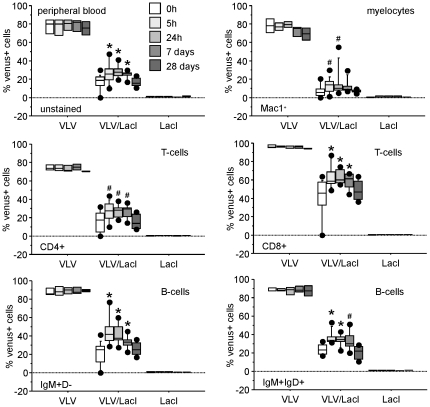
Transgene re-expression in vivo.Mice of the indicated genotypes were treated i.p. with 1 mg IPTG and levels of Venus+ cells in T-, B- and myeloid subsets in the peripheral blood were quantified by FACS analysis following the indicated times. Results of three independent experiments and 3 (VLV and LacI) or 6 (VLV/LacI) animals/genotype are represented as box plots. Box length equals interquartile range. Circles represent minimal and maximal values; *p<0.001; #p<0.05. F2 generation offspring of VLV founder A3 were crossed with LacI mice. Single-, double-, and non-transgenic littermates were used for analysis.